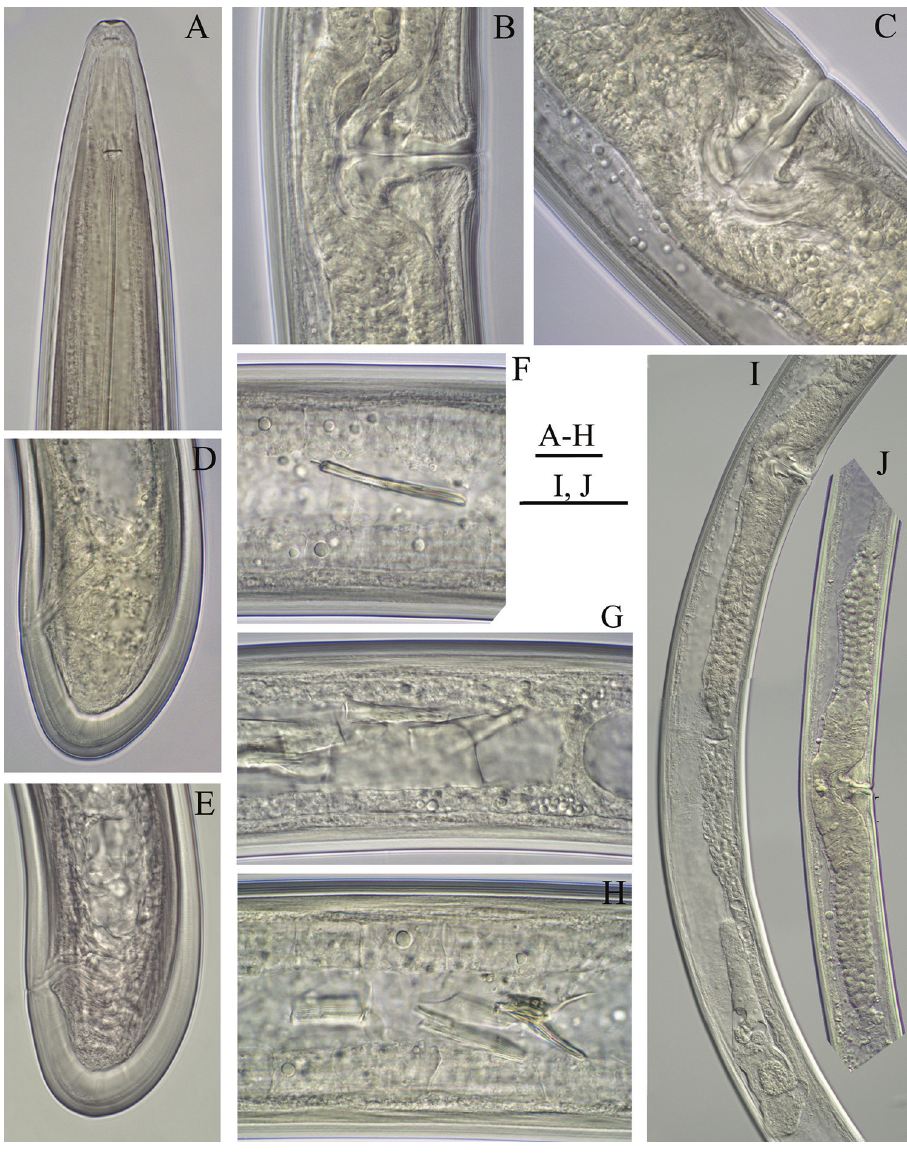
Figure 2. Longidorus polyae sp. n., female A anterior region B, C varia tions in vagina D, E variations in tail shape F–H intestine inclusions I posterior genital branch J part of reproductive system. Scale bars: 20 μm ( A–H ); 100 μm ( I, J